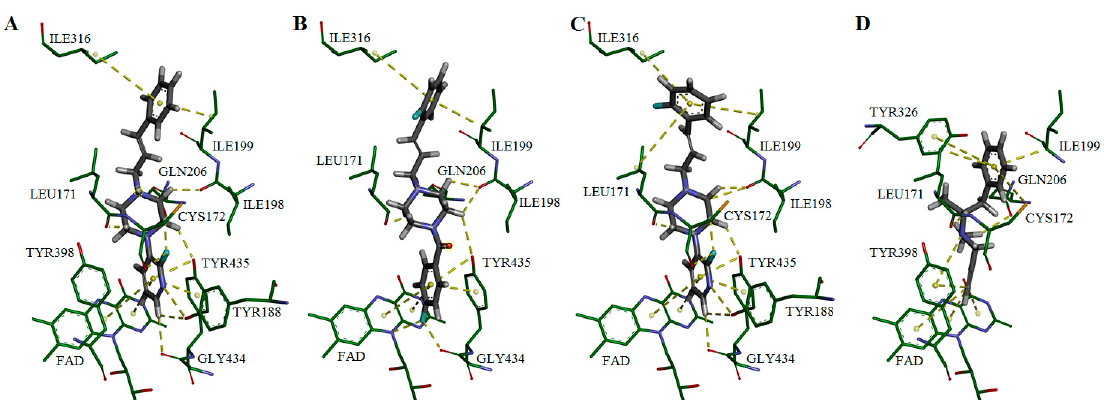
Figure 3. Docking poses of compound 12 ( A ), 13 ( B ), 17 ( C ) and L -Deprenyl ( D ) in the human MAO-B substrate binding site; ligand (grey) and key residues (green) are represented as stick models, while ligand interactions are shown as dashed lines (yellow).